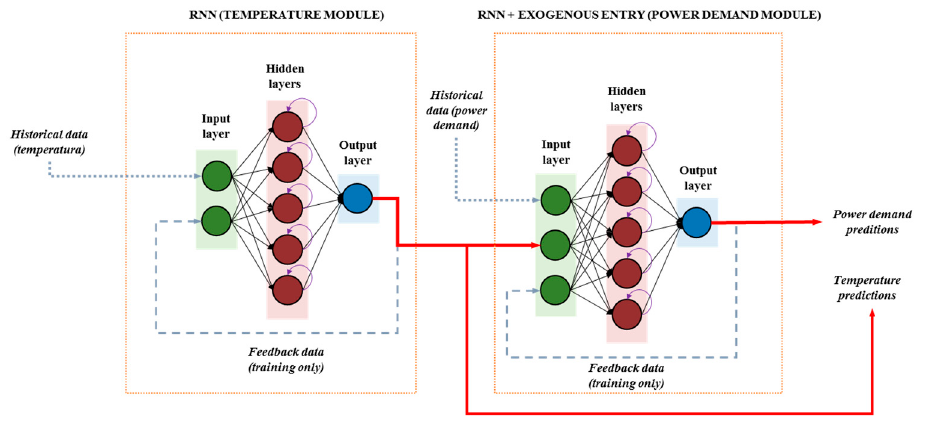
Figure 3. Proposed neural network architecture.